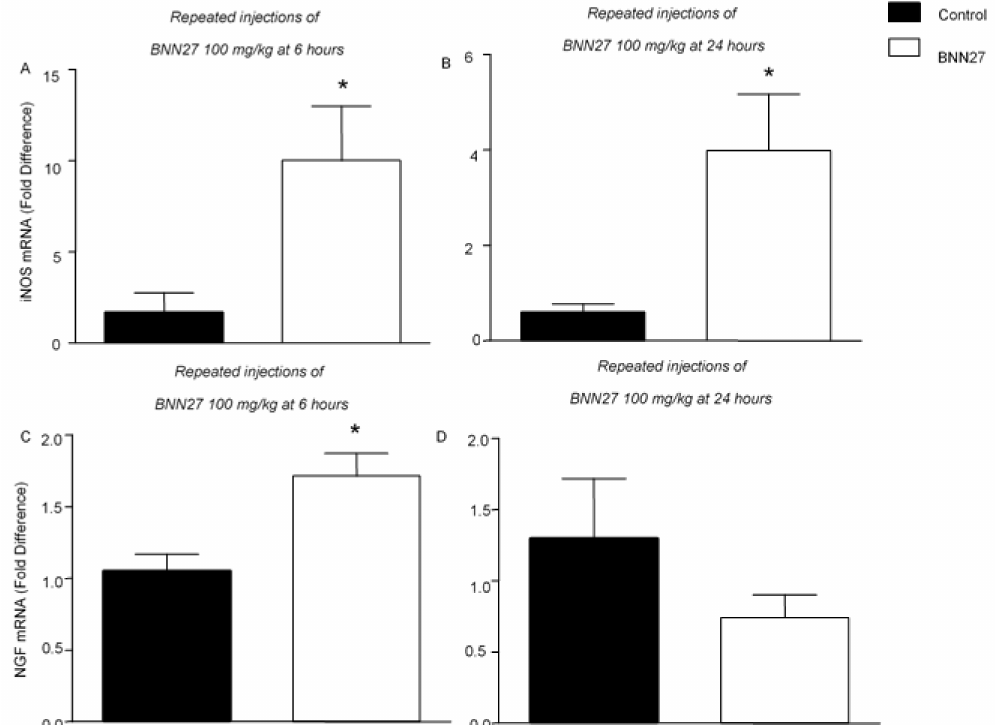
Figure 5. Effect of BNN27 on inflammatory mediators. Repeated injections with BNN27 100 mg/kg increased the iNOS mRNA levels in the inflamed paw at 6 ( A ) and 24 ( B ) hours following CFA injection. NGF mRNA in the inflamed paw was increased following treatment with BNN27 100 mg/kg at 6 h ( C ) but not at 24 ( D ). ( A ) Control n = 4 mice, BNN27-treated group n = 4 mice; ( B ) Control n = 4 mice, BNN27-treated group n = 5 mice; ( C ) Control n = 4 mice, BNN27-treated group n = 4 mice; ( D ) Control n = 4 mice, BNN27-treated group n = 5 mice. In all panels * p < 0.05. Statistical analysis was performed using unpaired t -tests. All data are expressed as the mean ±